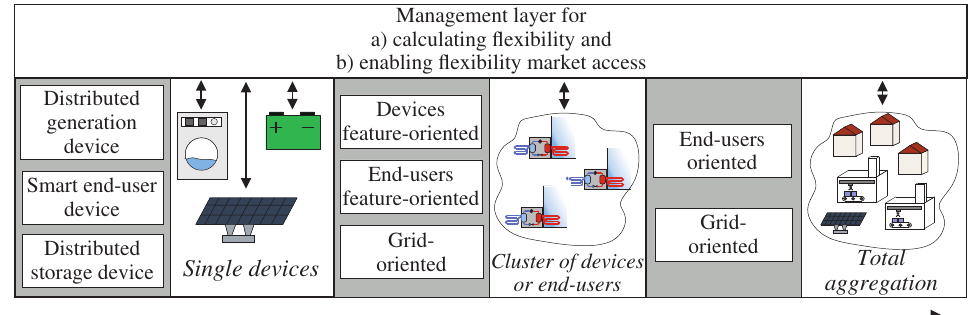
Figure 1. Categorization of flexibility